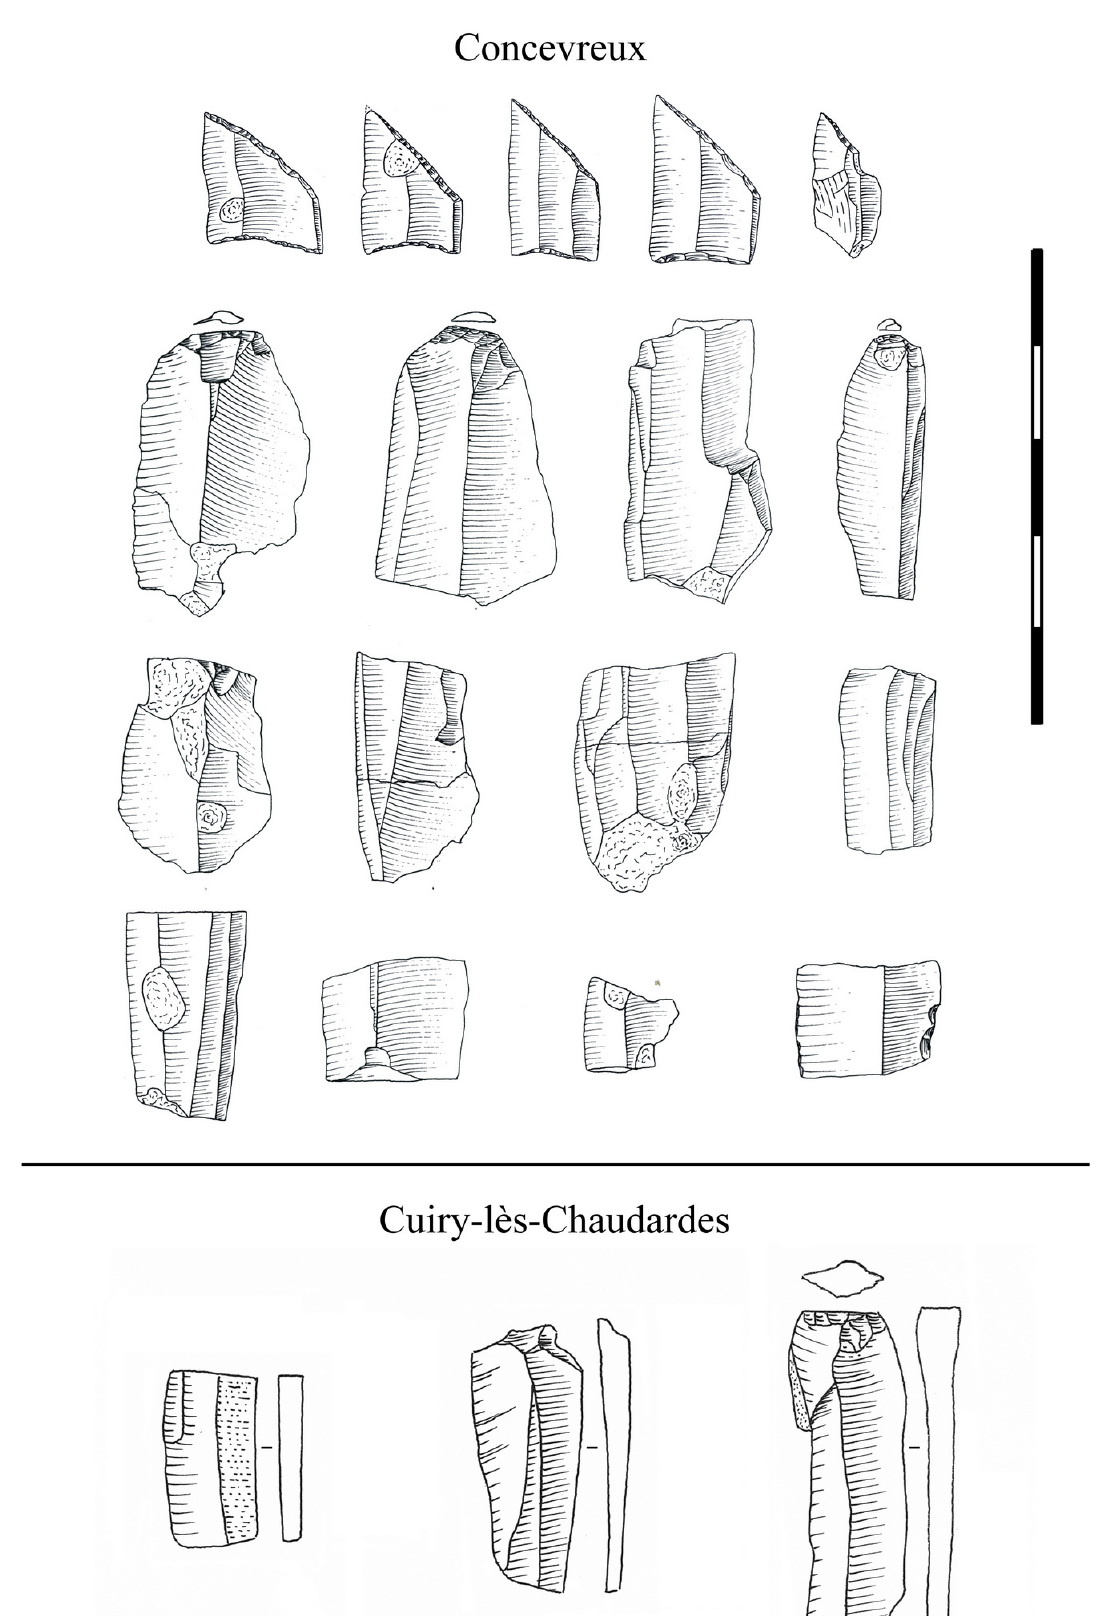
Figure 10. Mobilier lithique des sépultures mésolithiques de Concevreux (Robert et al. 2015) et de Cuiry-lès- Chaudardes (Ilett 1998). Etudes et dessins P. Allard. (L’échelle est de 5 cm divisée en segments de 1 cm.) Figure 10. The lithic material of the Mesolithic graves of Concevreux (Robert et al. , 2015) and Cuiry-lès- Chaudardes (Ilett 1998). Studies and drawings P. Allard. (Scale bar is 5 cm wide, divided into 1 cm Journal of Lithic Studies (2017) vol. 4, nr. 2, p. xx-xx doi:10.2218/jls.v4i2.2538